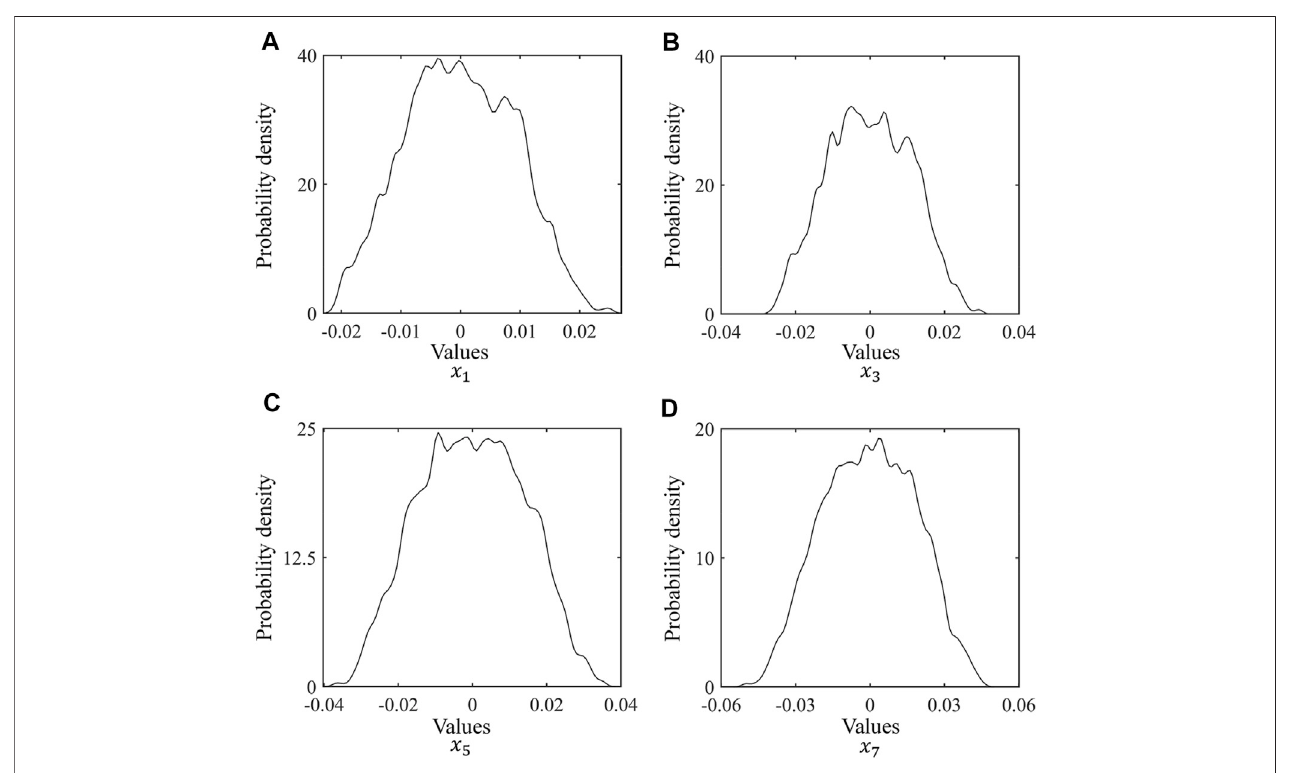
FIGURE 5 | Probability density distributions of output sequences. (A) , the probability density distributions of the output sequence x 1 . (B) , the probability density distributions of the output sequence x 3 . (C) , the probability density distributions of the output sequence x 5 . (D) , the probability density distributions of the output sequence x 7